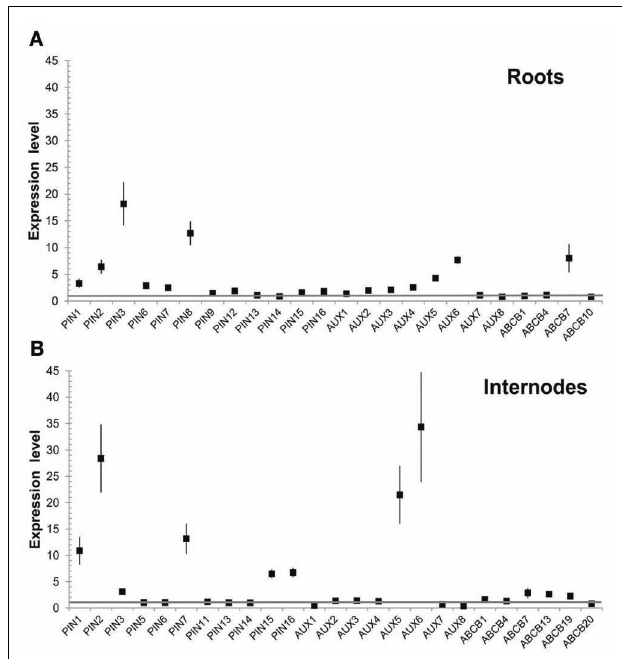
FIGURE 9 | Upregulation of putative auxin transporters expression following IAA treatment. Several PtaPIN , PtaAUX/LAX , and PtaABCB genes showed increased transcript levels in response to exogenous IAA in both roots and internodes.Two-month-old Populus tremula × alba were grown in the greenhouse and root tips and internodes were collected and incubated at room temperature in liquid growth media with or without 30 μ M IAA for 6h in the dark. Assays were run in triplicates. Bars represent SEM. Gene expression in the IAA treated tissue is reported relative to the untreated tissue according to the comparative quantitation